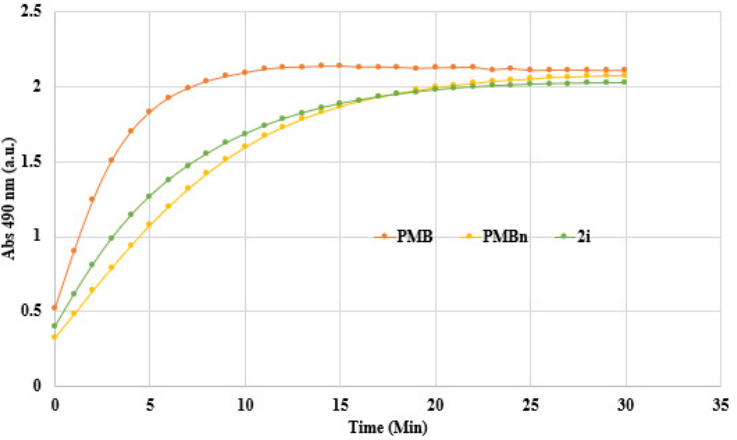
Figure 1. Nitrocefin hydrolysis kinetics in presence of compounds 2i at 18 µg/mL and compared to PMB and PMBn.